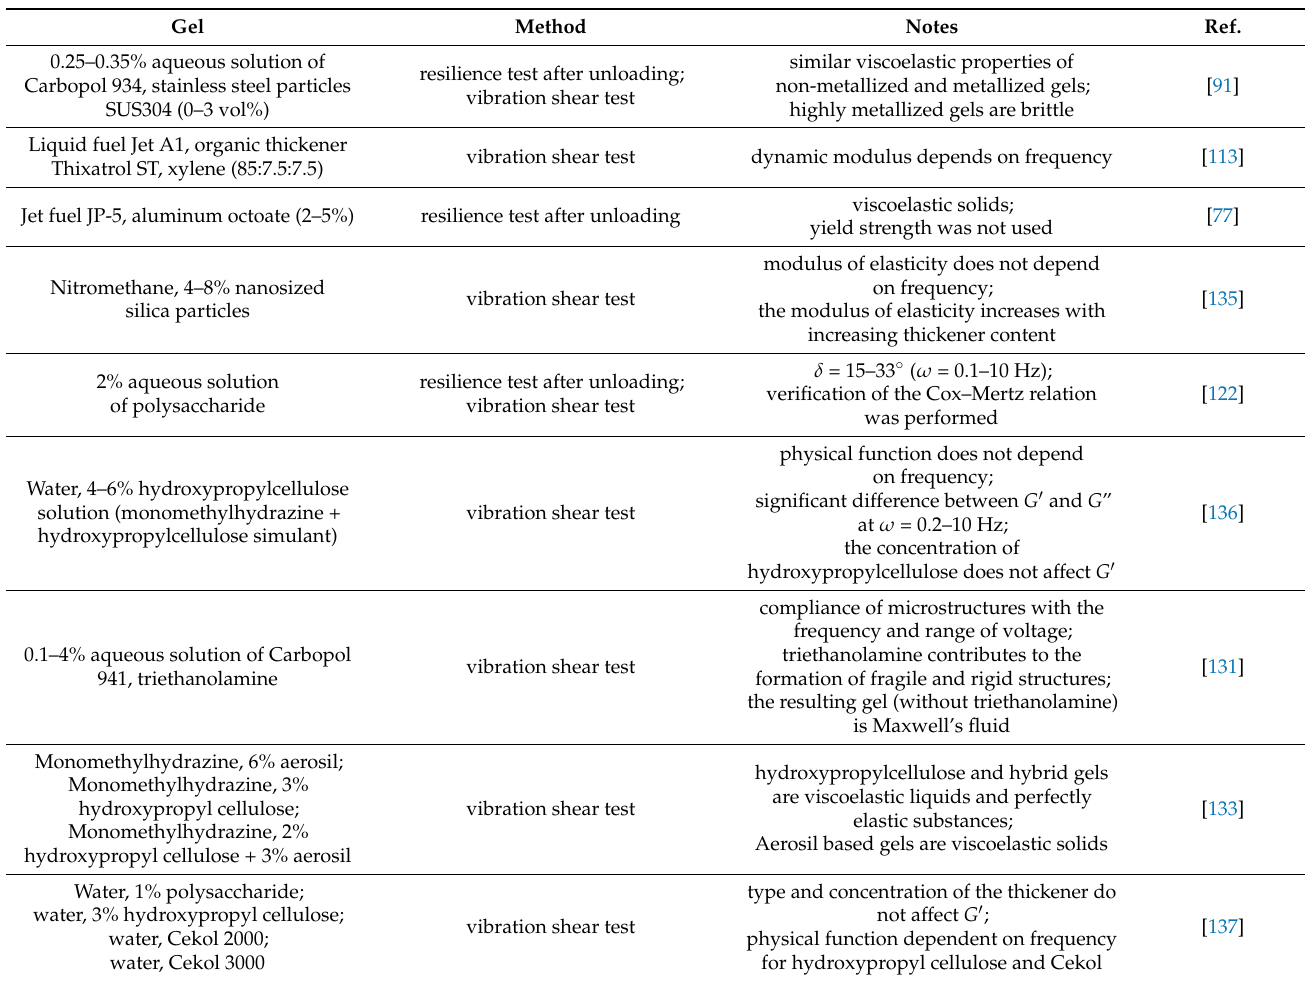
Table 2. Viscoelastic properties of gel fuels and their